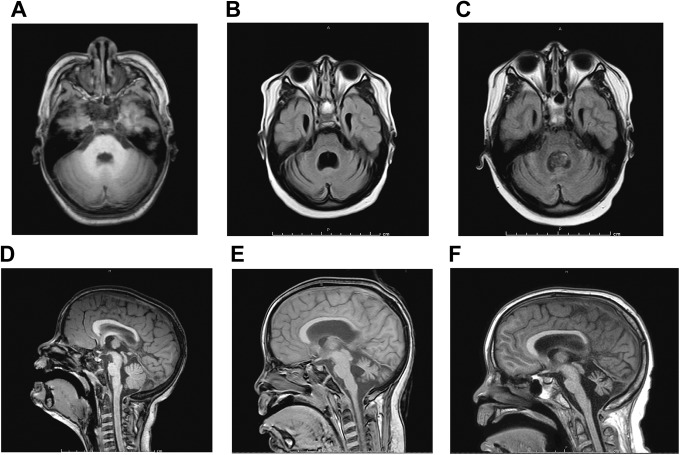
MRI axial and sagittal FLAIR imaging. A, Pre-PCD axial T1 image at time of ataxia
onset, 2 months prior to Purkinje cell cytoplasmic antibody type 1 diagnosis (5.5
years ago). Patient had known congenital dilatation of the lateral ventricles,
particularly occipital horns. The size of the ventricles remained stable over years
with no need for neurosurgical intervention. B, MRI was performed 9 months after onset
of symptoms at time of most severe ataxia (5 years ago). It was diagnostic for PCD; T2
image shows cerebellar atrophy with enlargement of fourth ventricle. C, MRI T2 axial
image 8 months after acute lymphocytic leukemia diagnosis at time of cytosine
arabinoside encephalopathy (1 year ago). Cerebellar volume remained stable when
compared to MRI 4 years prior. D, Sagittal image from MRI at onset of ataxia
(corresponding to A). Cerebellar vermian volume appears normal. E, On the sagittal
image (corresponding to B), there is notable progression of cerebellar vermian atrophy
after progression of PCA-1 disease. F, The sagittal image from MRI 1 year ago
(corresponding to C) shows no interval change after immunotherapy and systemic
chemotherapy. Although only a single image can be shown here, when the entire 2 MRI
studies (sagittal, axial, coronal images) were compared with our radiologist, they
look remarkably similar, including the dimensions of the vermis and fovea. Despite the
severe vermian volume loss, the patient has mild ataxia with minimal impact on the
quality of daily life. MRI indicates magnetic resonance imaging; PCA-1, Purkinje cell
cytoplasmic antibody type 1; PCD, paraneoplastic cerebellar degeneration.